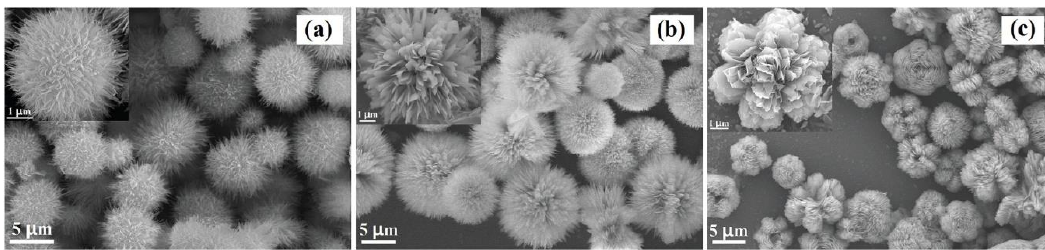
Figure 22. SEM images of the precursors of ZnO nanostructures synthesised with different dosages of urea: ( a ) 0.3 g, ( b ) 3.0 g, ( c ) 6.0 g. Reprinted from [654], Copyright (2014), with permission from